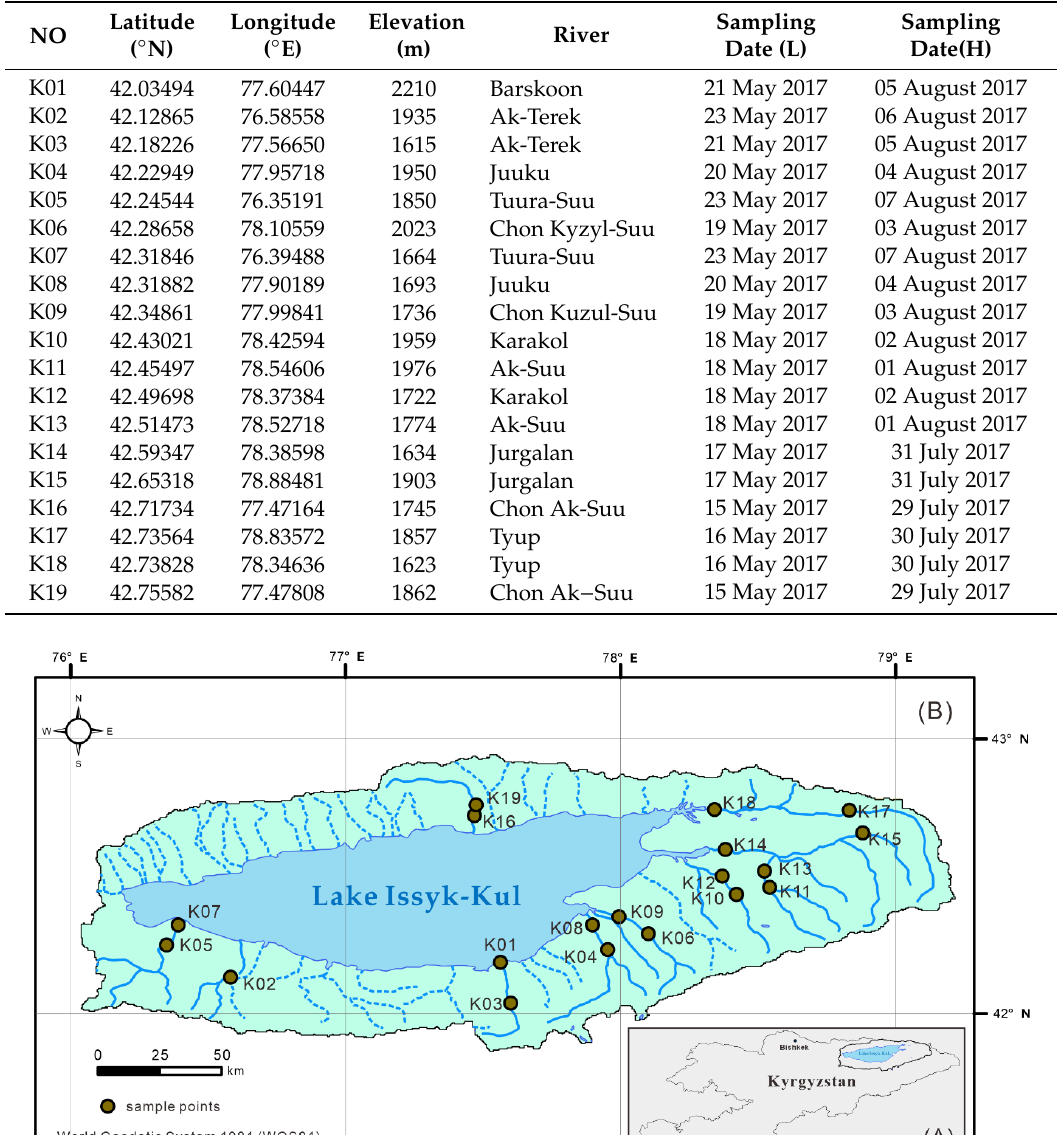
Table 1. Geographic information for sampling points in the Issyk − Kul Basin during the period with low river flow (L) and period with high river flow (H).